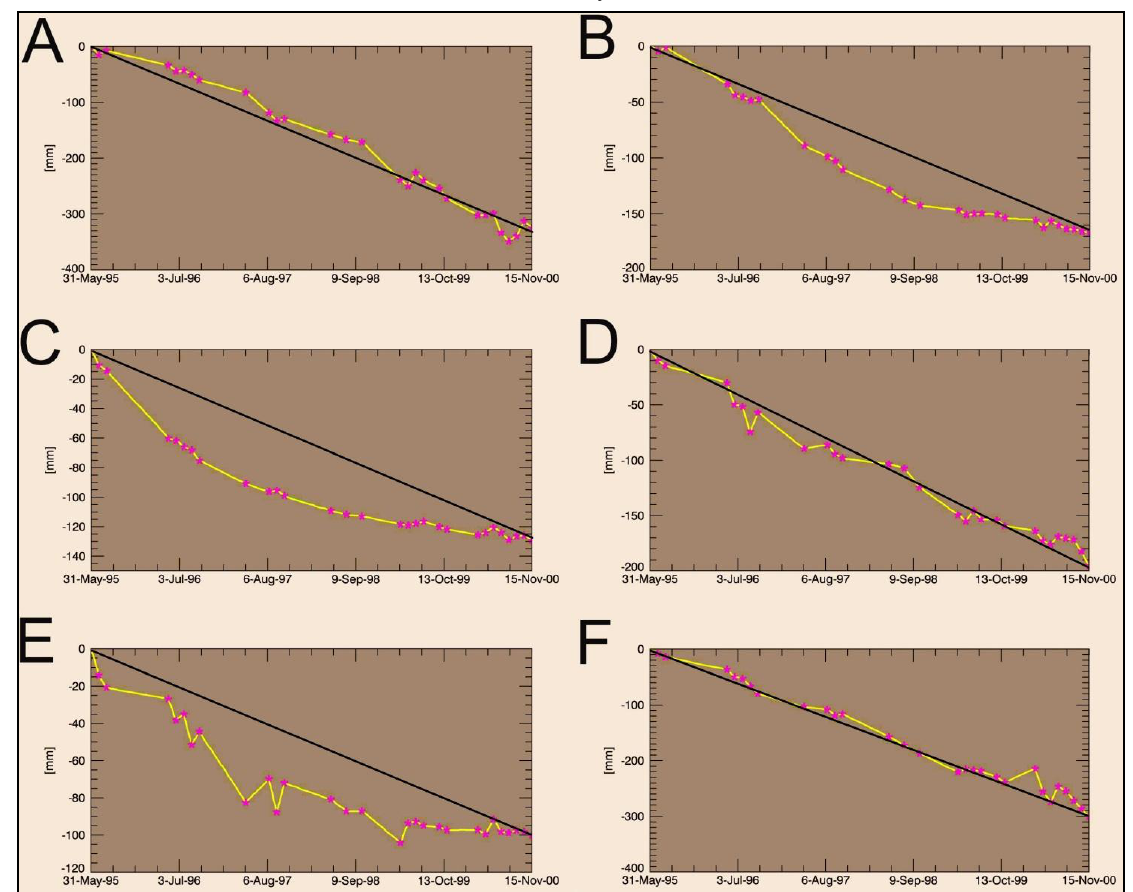
Fig. 6. The selected representative points for time series analysis from Bytom (A, B); Ruda Śląska (C, D) and Katowice (E, F)